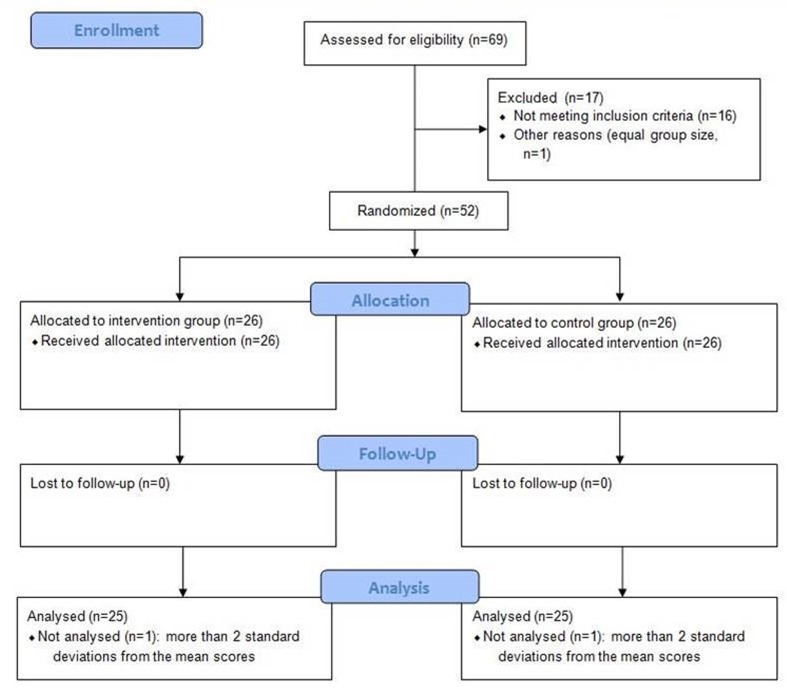
Study flow diagram.